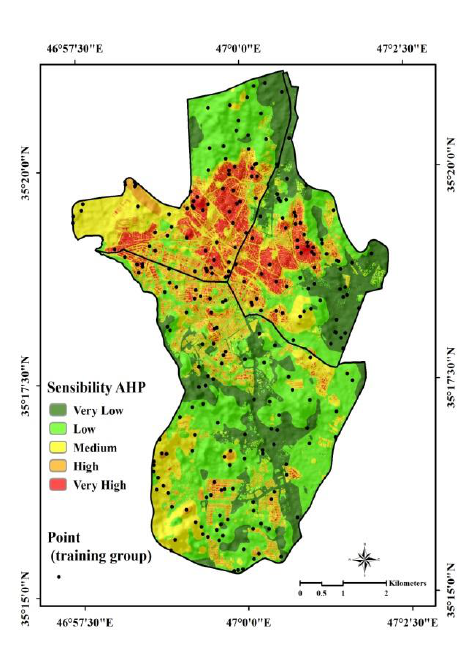
Figure 5. Training sites created via the AHP